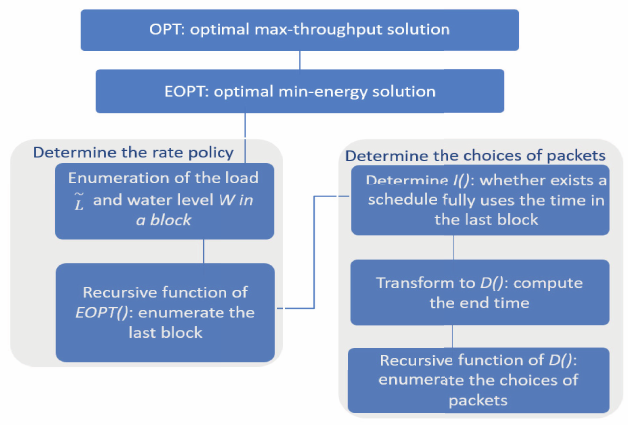
Figure 3. A flowchart showing the design of